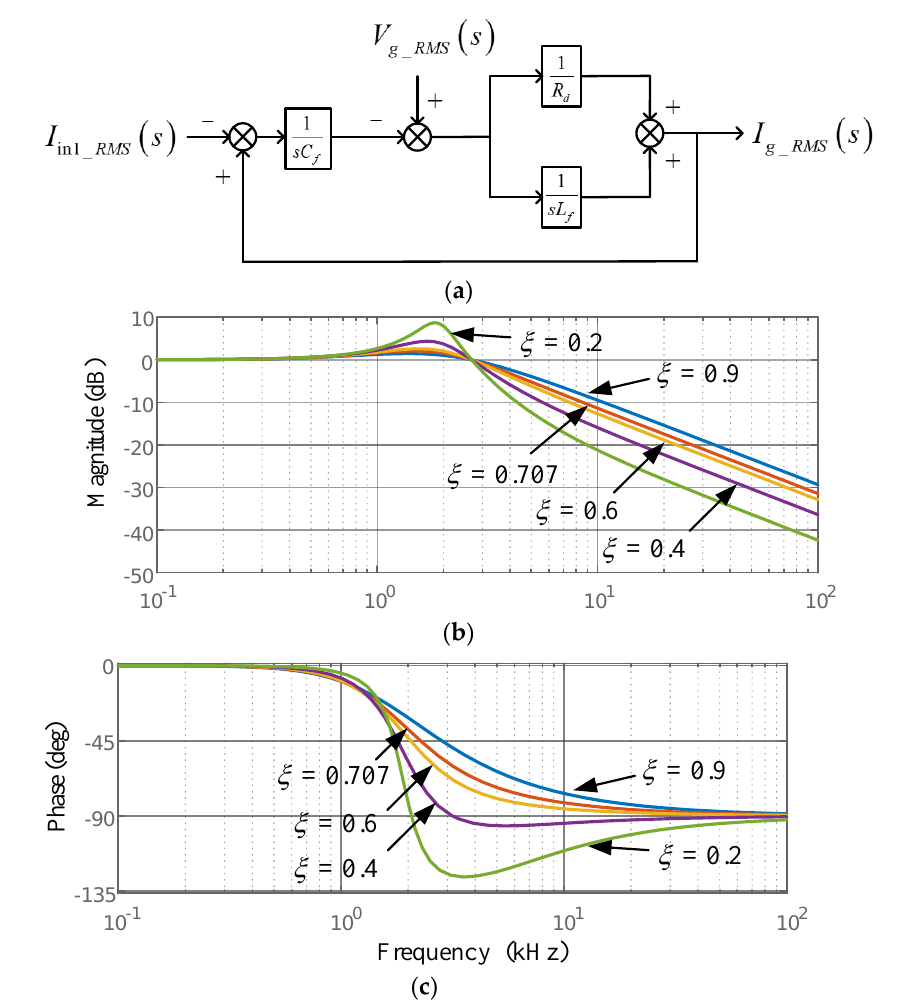
Figure 5. Three-phase R-L-C filter using method 2. ( a ) Equivalent diagram, ( b ) amplitude response, ( c ) phase response.